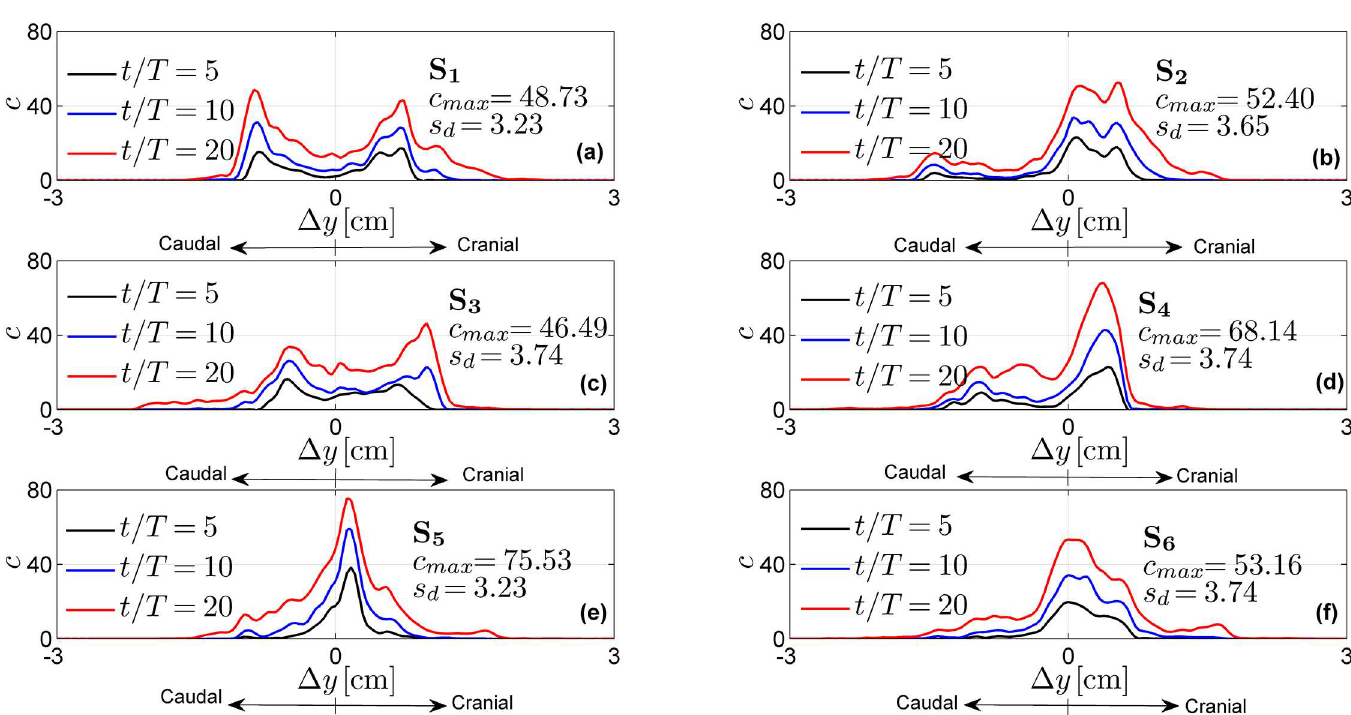
Fig 5. Normalized drug concentration profiles as a function of the distance Δ y from the injection point for different injection positions. The profiles are obtainedwith test cases S 1 -S 6 .